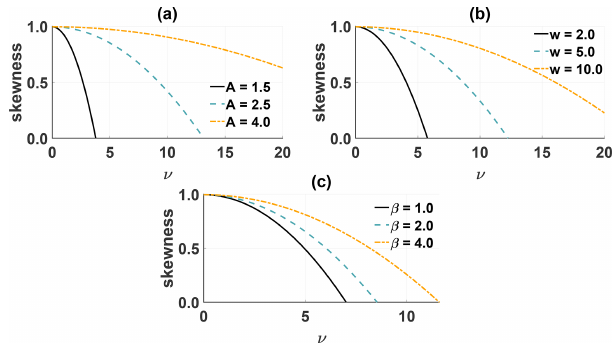
Figure 14. Skewness as a function of the kinematic viscosity for different values for the amplitude (a) , width (b) and plasma β (c)